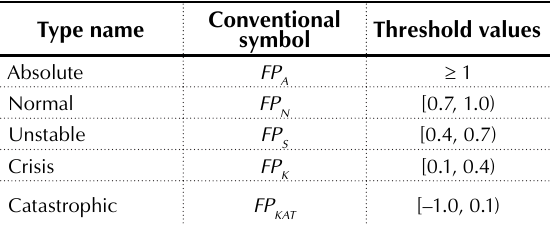
Table 1. Threshold values of the socio-economic